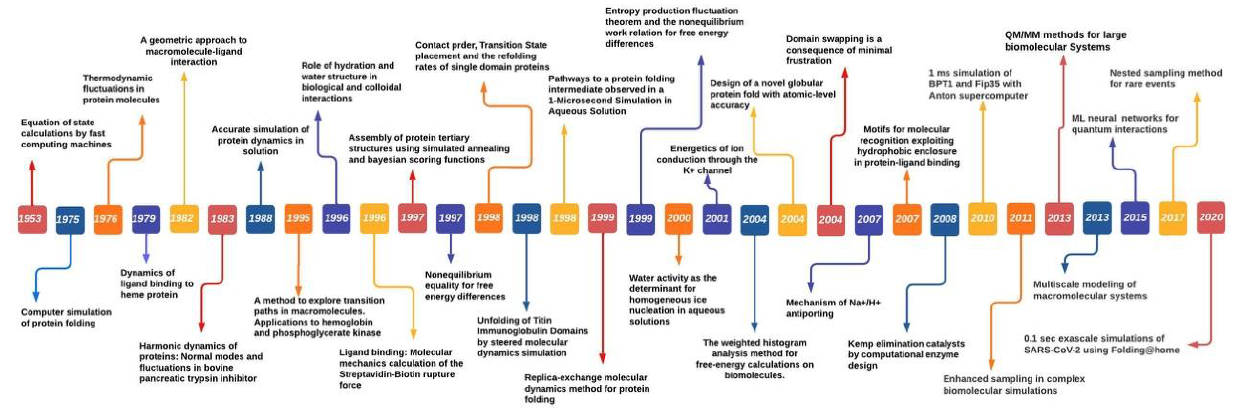
Figure 2. The Molecular Simulations timeline showing the breakthrough achievements in MD Simulation studies.